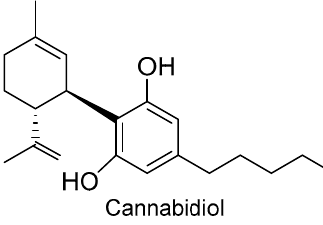
Figure 8. Structure of cannabidiol.